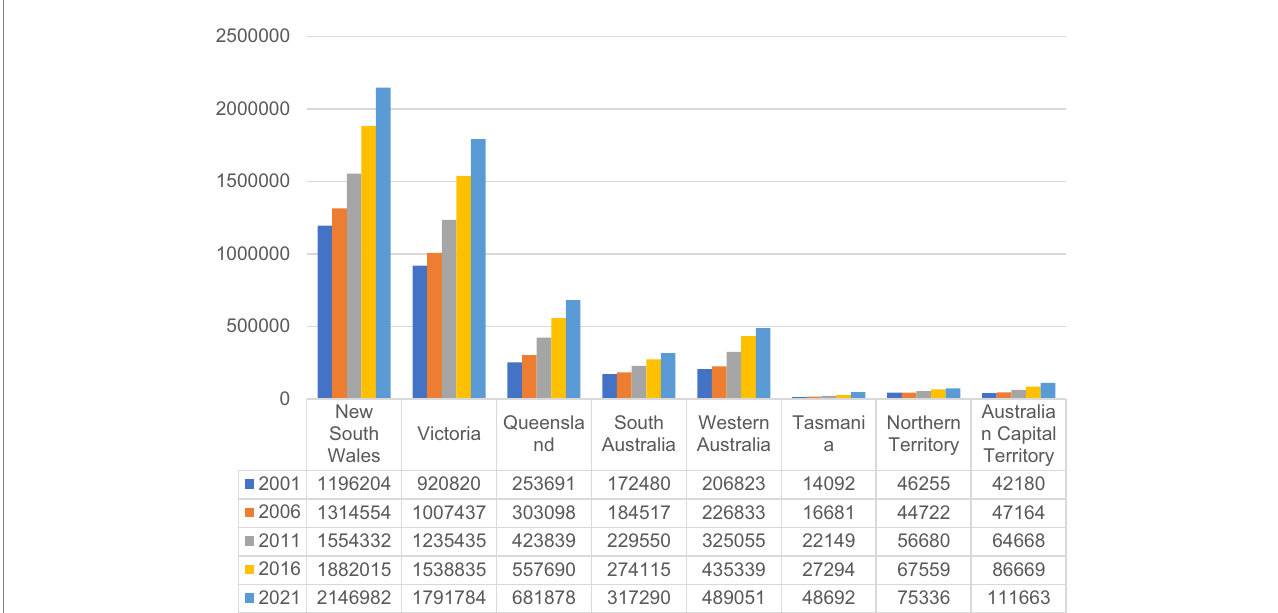
FIGURE 1 Home language speakers of LOTE by